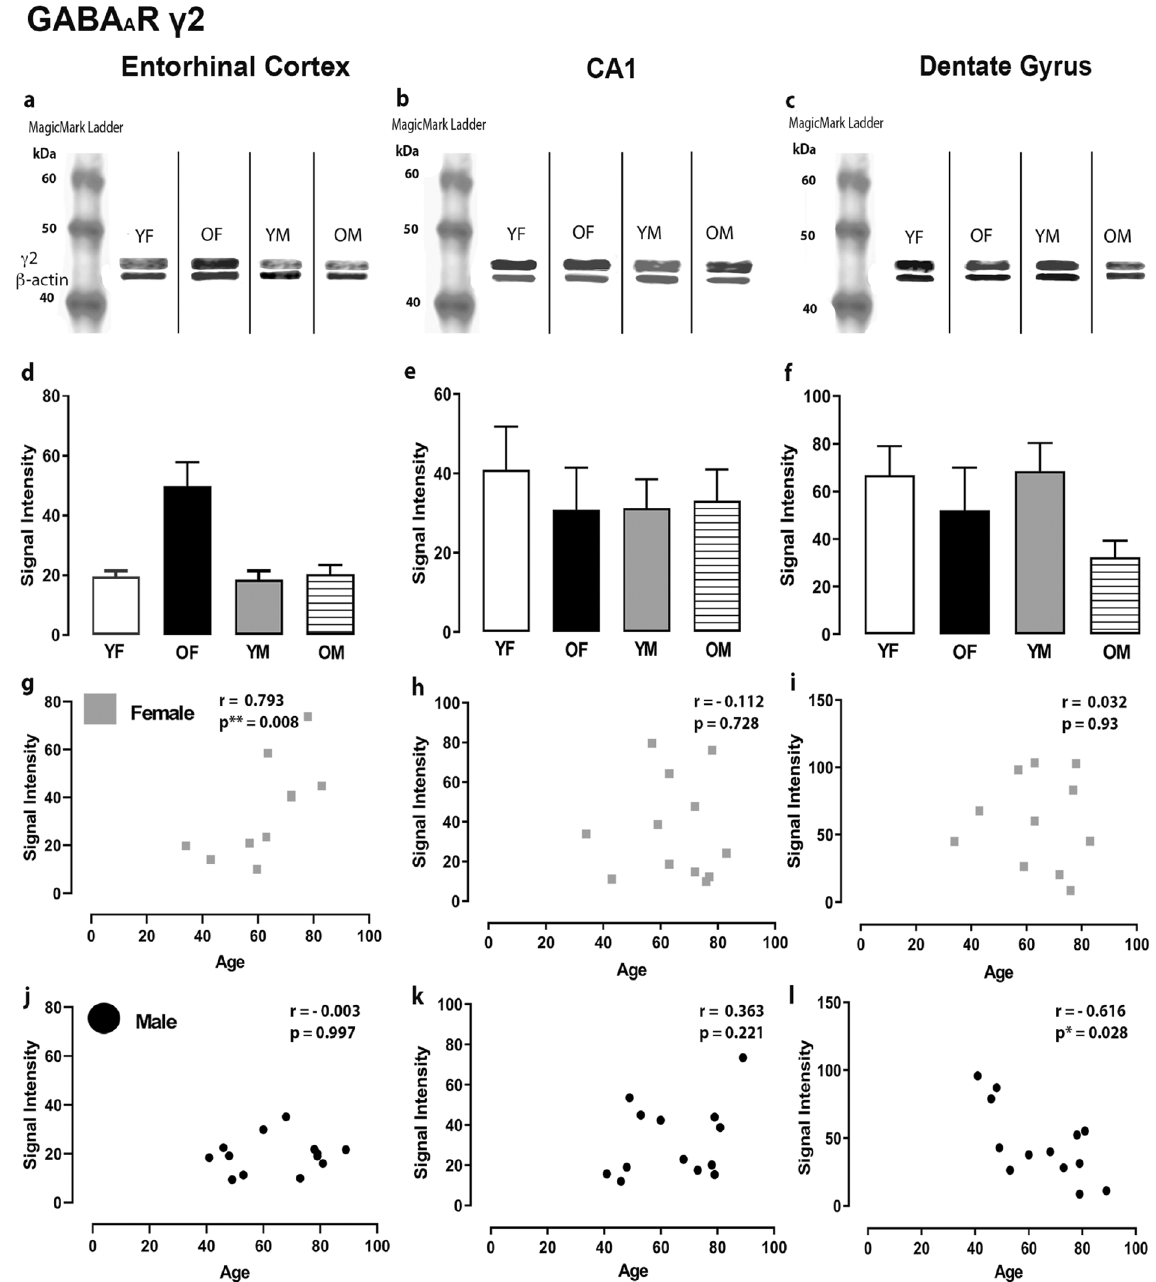
Figure 4. Expression of the GABA A R γ2 subunit in the entorhinal cortex, hippocampal CA1 region and dentate gyrus. ( a , b , c ) Representative immunoreactive Western Blot bands from younger female (YF), older female (OF), younger male (YM) and older male (OM) tissue homogenates of the ECx, CA1 and DG regions, following incubation with GABA A R γ2 antibody. GABA A R γ2 and corresponding β-actin band (γ2 band size- ~ 44 kDa, β-actin band size ~ 42 kDa) are shown. Each lane was loaded with 20 µg of protein. ( d , e , f ) Signal intensity graphs for each group comparing GABA A R γ2 Western Blot band was measured and normalised to their corresponding β-actin signal for each age group. The data is graphed as mean ± SEM (N = 4–7). ( g , h , i , j , k , l ) Correlation graphs for males and females plotting the relationship between age and signal intensity of GABA A R γ2 bands (p * ≤